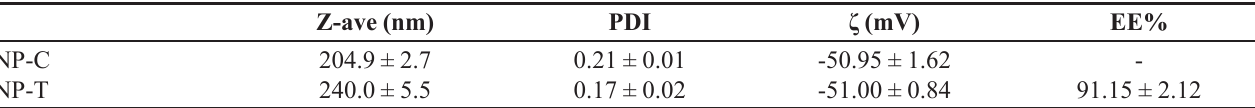
TABLE I - Results for mean particle size (Z-ave), polydispersity index (PDI), zeta potential (ζ) and encapsulation efficiency (EE%) for PCL nanoparticles